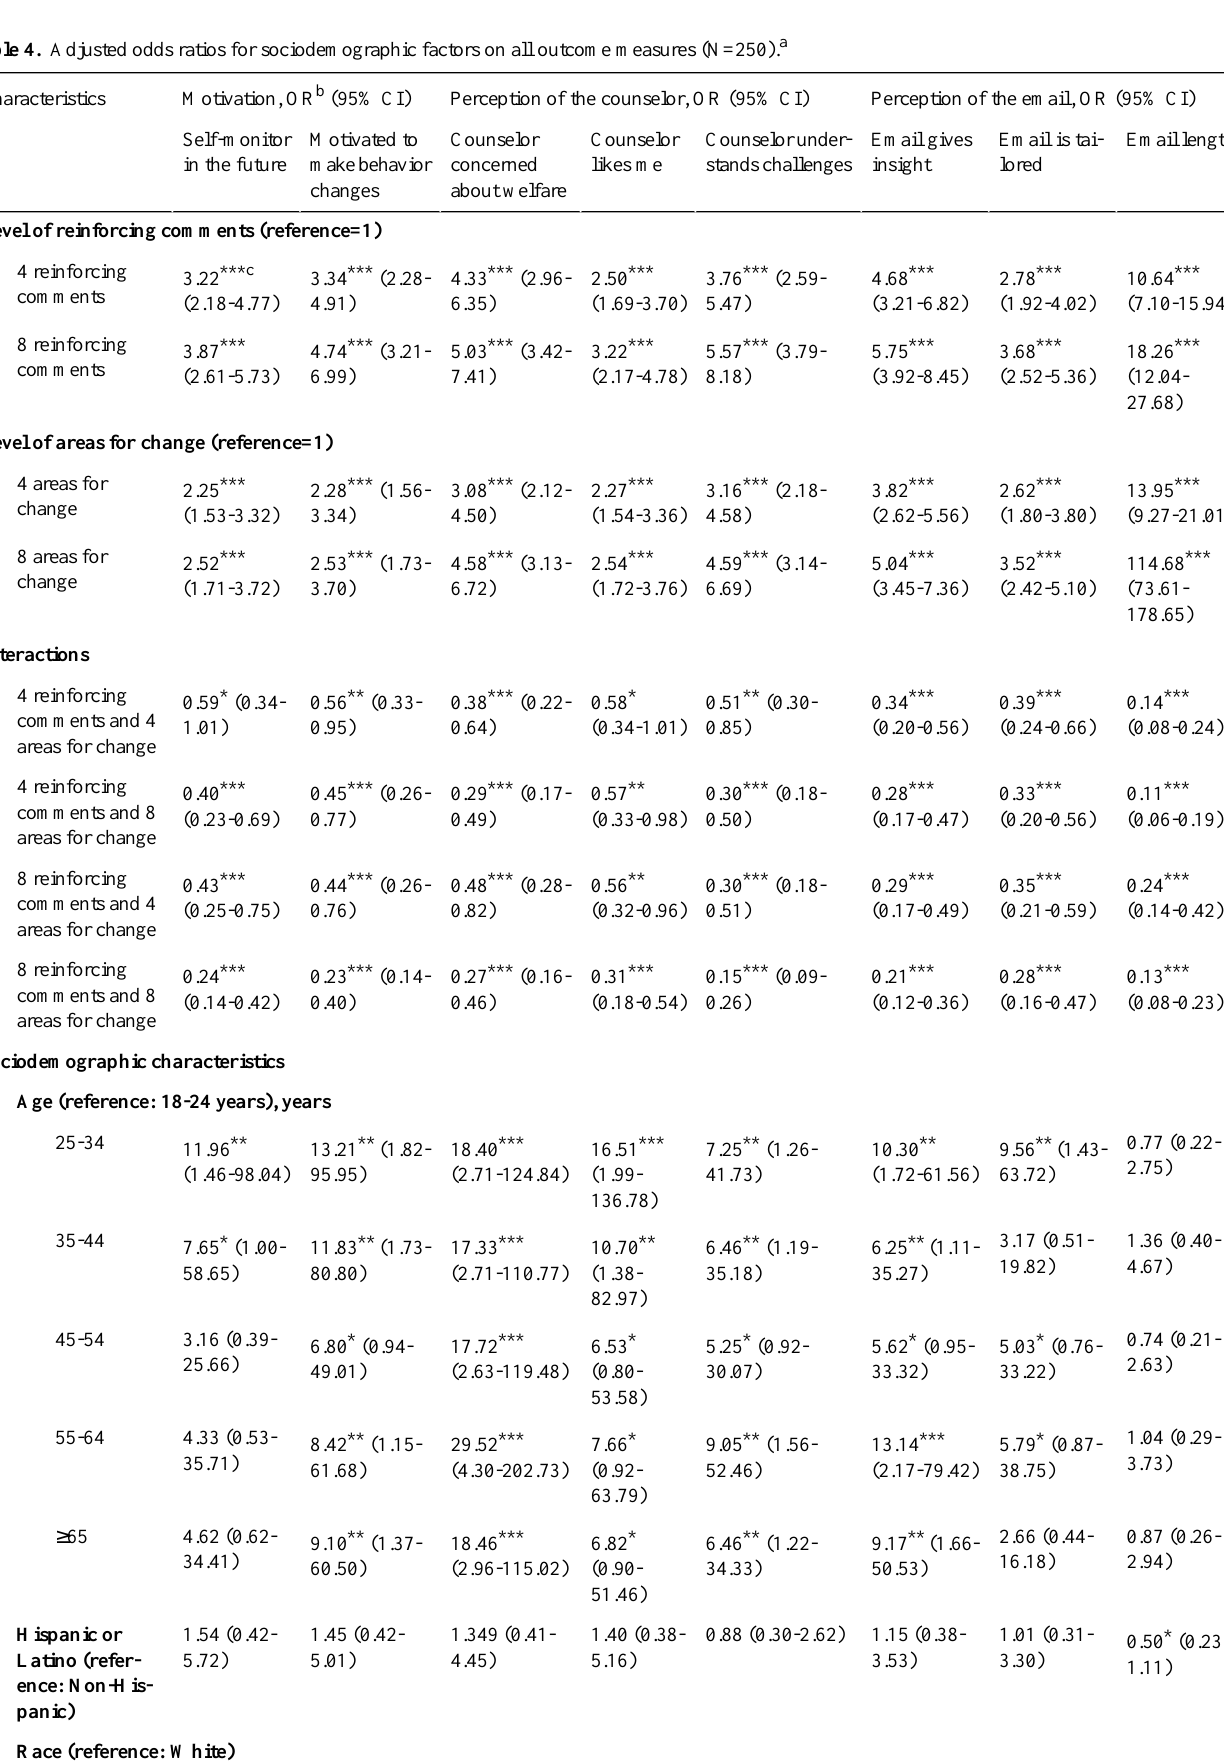
Table 4. Adjusted odds ratios for sociodemographic factors on all outcome measures (N=250). a